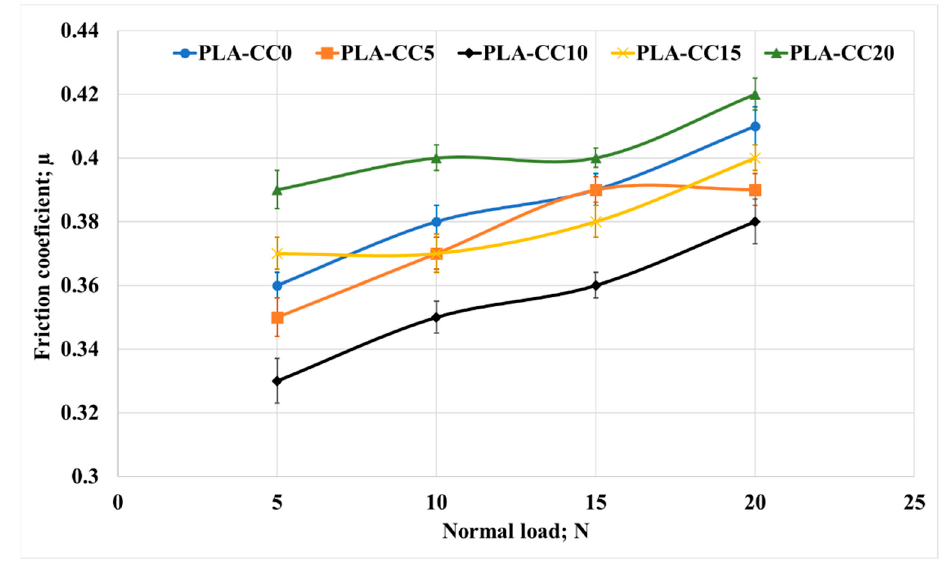
Figure 14. Friction coefficient of PLA-CC composites under different normal loads.